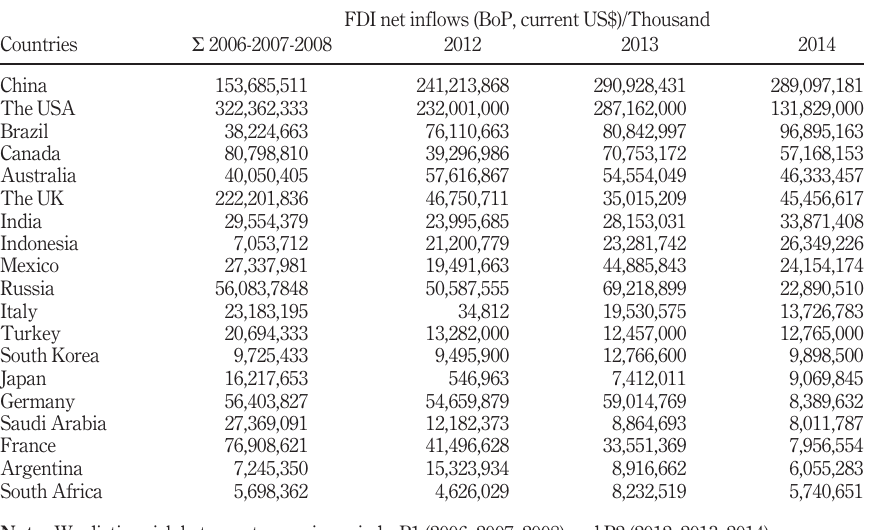
Table II. FDI In fl ows for the G-20 (19)